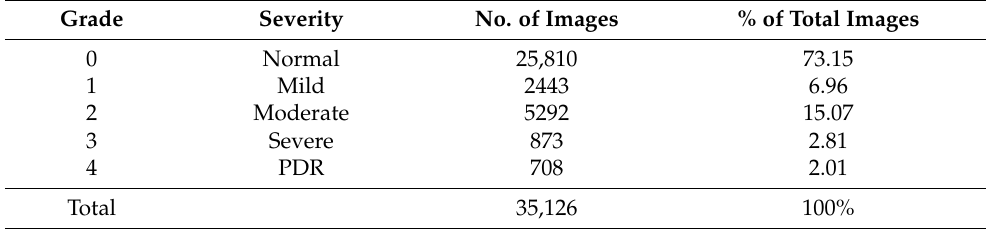
Table 1. Kaggle EyePACS dataset details.